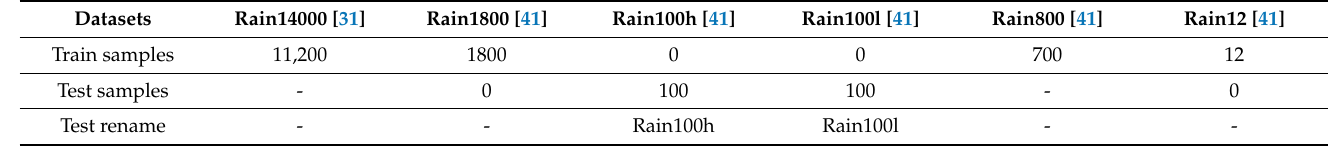
Table 1. Description of datasets used for synthesis rain images.